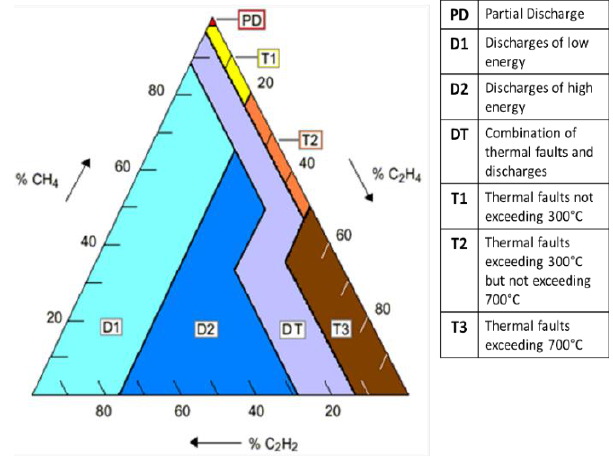
Figure 1. Duval triangle and associated fault zones.